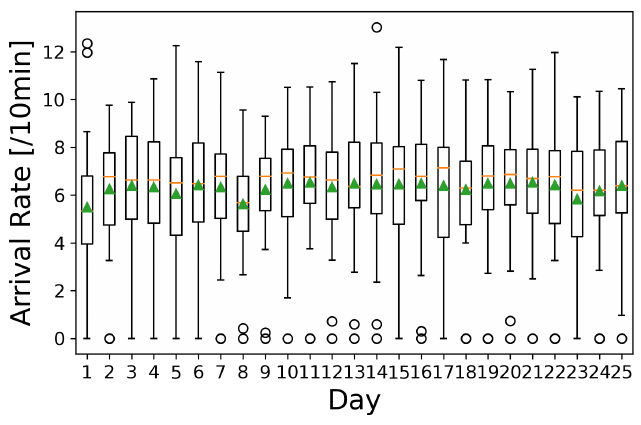
Figure 4. Boxplot of λ i ( t ) (1 ≤ i ≤ 25).